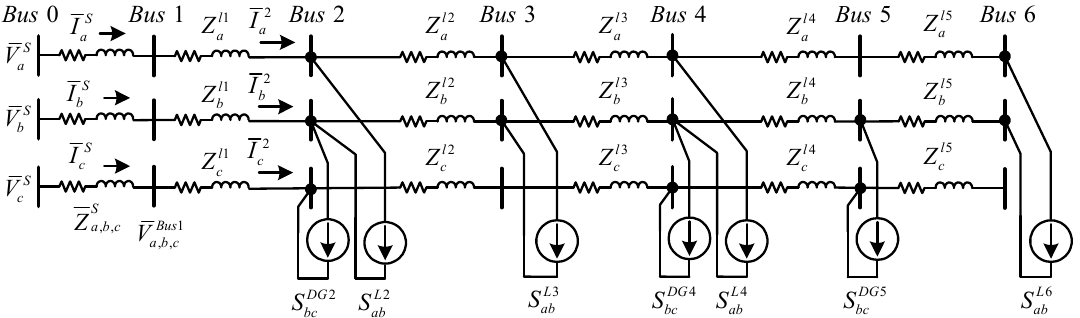
Figure 7. Microgrid study system with unbalanced DGs and loads.